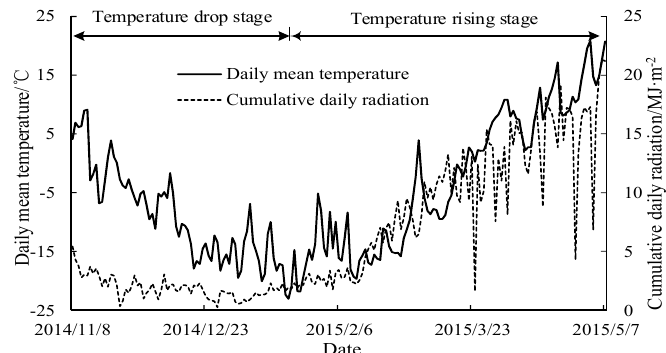
Figure 3. Daily average temperature and daily total radiation variation in the test period.